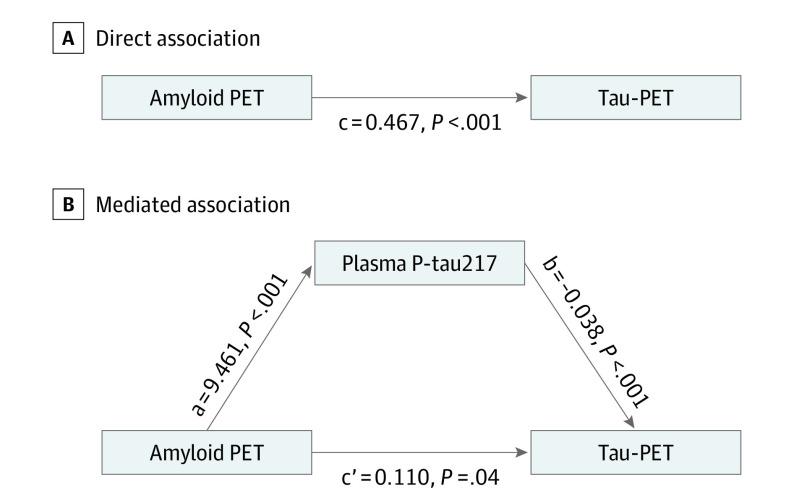
Mediated Effect of Plasma Tau Phosphorylated at Threonine 217 (P-tau217) on the Association of Amyloid-β (Aβ) Positron Emission Tomography (PET) With Tau-PETMediated effect of plasma P-tau217 on the association of Aβ-PET with tau-PET in cognitively unimpaired participants and in those with mild cognitive impairment (n = 484). A, The direct association (c) of Aβ-PET with tau-PET. B, The mediated effect of plasma P-tau217 is designated c-c′. The remaining association of Aβ-PET with tau-PET after adjusting for plasma P-tau217 is designated c′. The direct association of Aβ-PET with plasma P-tau217 is a, and the association of plasma P-tau217 with tau-PET is b (c-c′ = 0.357; 95% CI, 0.281-0.435; 76.4%). This indicates that plasma P-tau217 mediated 76.4% of the effect of Aβ-PET on tau-PET.